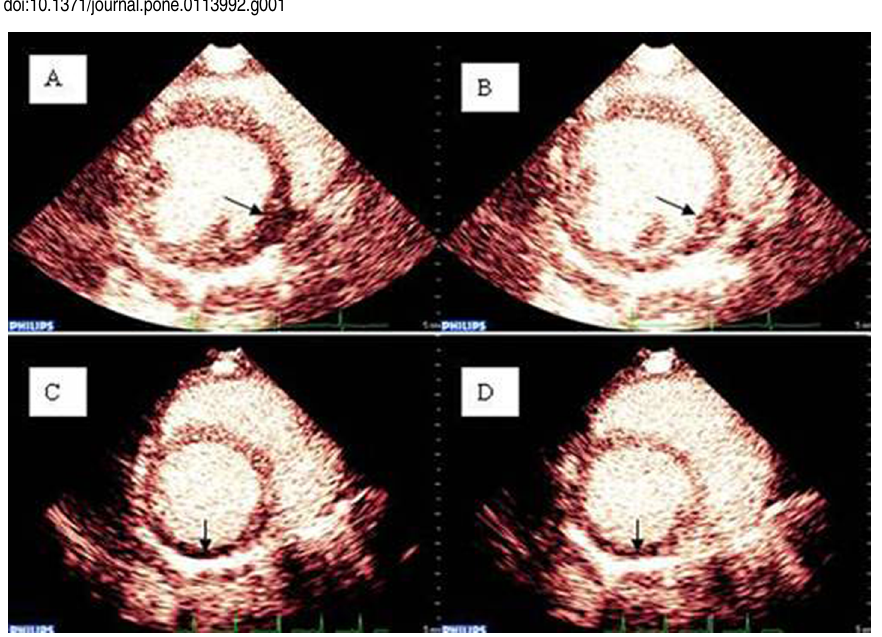
Figure 2. An illustration of RT-MCE between the CRT and control groups. The arrows indicate the ischemic areas. The images in A and B show the improvement of myocardial perfusion before and after bi- ventricular pacing in the CRT group (MBF: 23 dB/S vs. 58 dB/s). The images in C and D show no significant improvement of myocardial perfusion in the ischemic area of the control group (MBF: 19 dB/S vs. 23